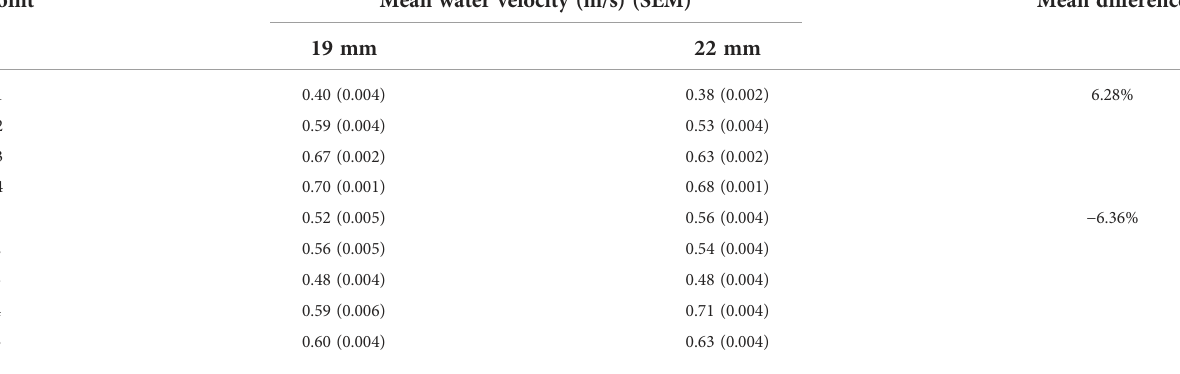
TABLE 2 Mean water velocity (m/s) and standard error of the mean (SEM) for the different points of measurement, and total mean water velocity difference between grids in front and behind the grids. Point